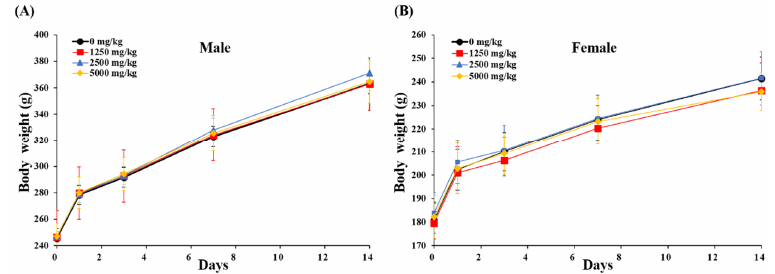
Figure 2. Body weight change of male ( A ) and female ( B ) rats in the single-dose oral toxicity test of BLE0. The day of administration was designated as day 0. Male and female rats were randomly divided into four groups ( n = 5/sex/group). Data are presented as mean ± standard deviation.